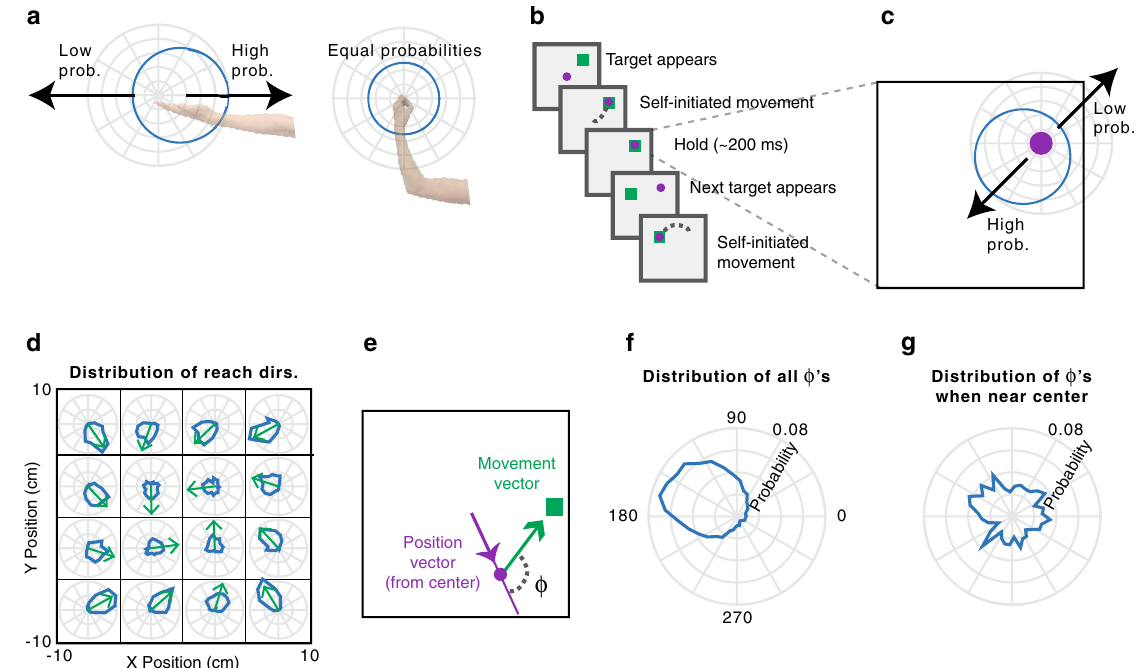
Fig. 1 Experimental design and statistics. a If the arm is outstretched, the only possible arm movements are back toward the body (left). In other limb postures, it may be possible to move the arm in any direction (right). In blue, circular probability distributions are shown for the possible upcoming movements based on the current arm posture. b Experimental design. The monkey makes sequences of four reaches, brie fl y holding within each target box before the next target appears. c The current hand position limits the range of possible locations of the next target, due to the borders of the workspace and target presentation algorithm. d The probability distributions of upcoming reach directions (blue) from different areas of space (x and y divided into quartiles). Green arrows point toward the circular means of the distributions. e Φ is the angular difference between the upcoming movement vector (the vector that brings the hand to the target) and the current angular hand position (relative to the center of the workspace). f The probability distribution of Φ ’ s from all hand positions. g The probability distribution of Φ ’ s from initial hand positions within 2 cm of the center of the